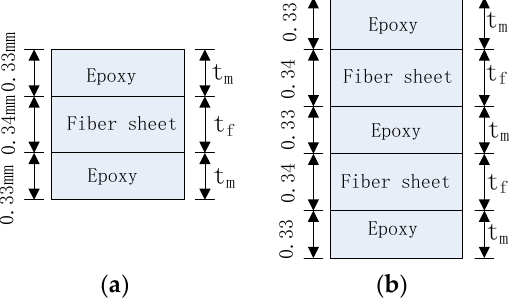
Figure 5. Layer scheme of the FRP lamina in a wet lay-up process: ( a ) One layer of fiber sheet; ( b ) Two layers of fiber sheets.